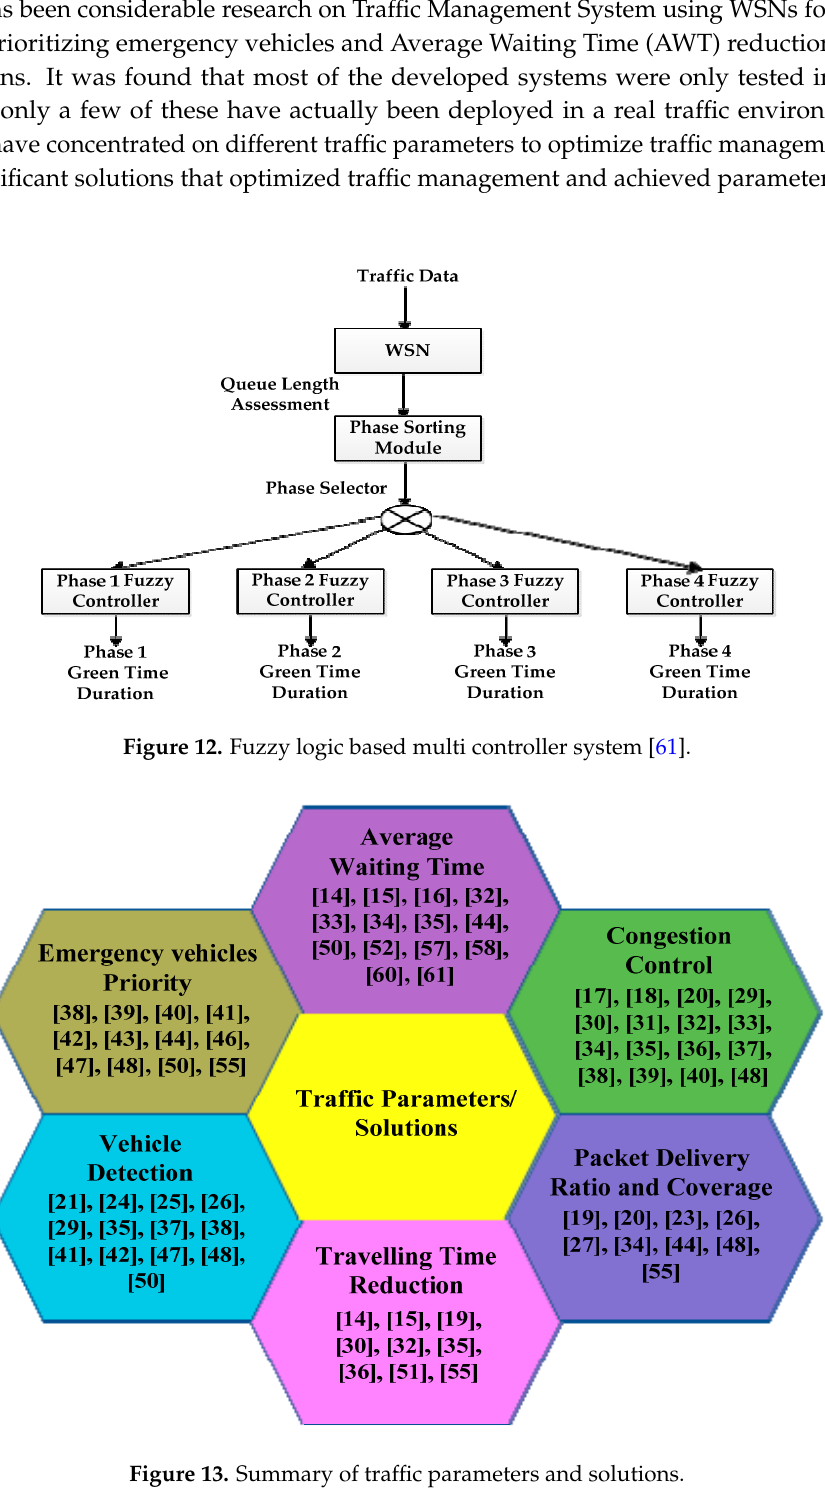
Figure 13. Summary of traffic parameters and solutions.